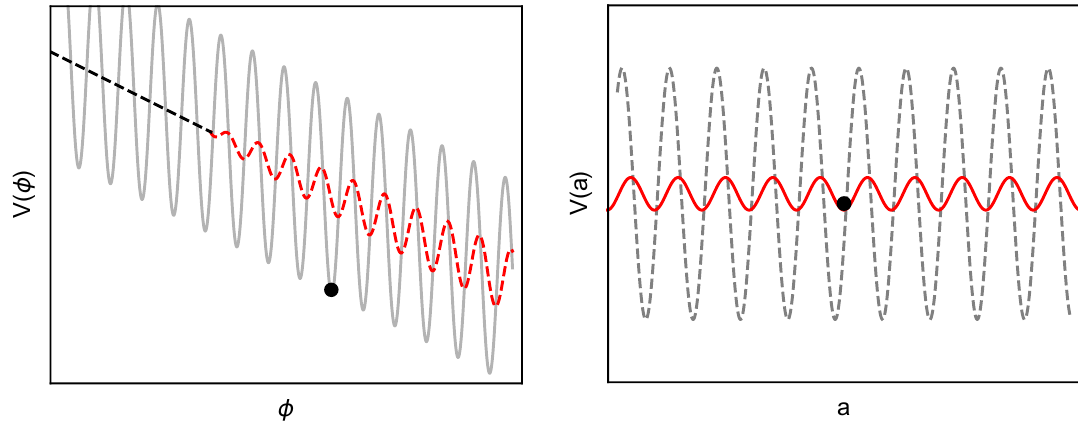
Figure 1 . Illustration of the cosmological relaxation of the electroweak scale in the PQ relaxion scenario where the QCD anomaly is responsible for selecting both the Higgs mass and the strong CP phase. The left (right) pannel shows the scalar potential along the direction of the relaxion (the QCD axion), where the dotted (solid) curves are the potential during (after) in(cid:13)ation. The red dotted and solid curve are the potential induced by the QCD anomaly during and after in(cid:13)ation, respectively, while the gray curves are those generated by an in(cid:13)aton-dependent coupling to hidden gauge anomalies. In the present universe, the relaxion (the QCD axion) is stabilized at the black dot in the left (right)